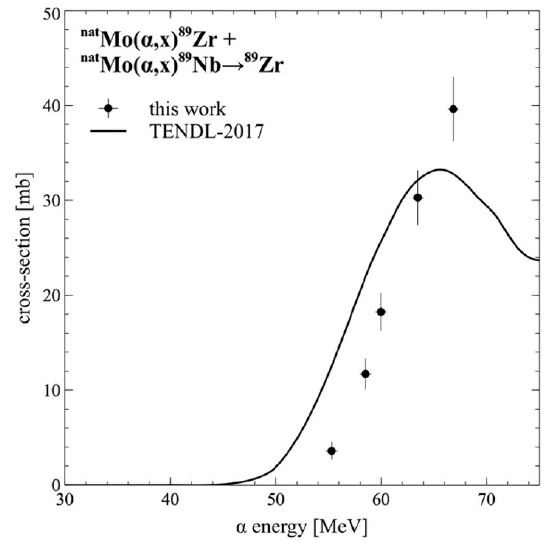
Figure 3. Measured cross-section for nat Mo( ⍺ ,x) 89g Zr reaction compared with TENDL.